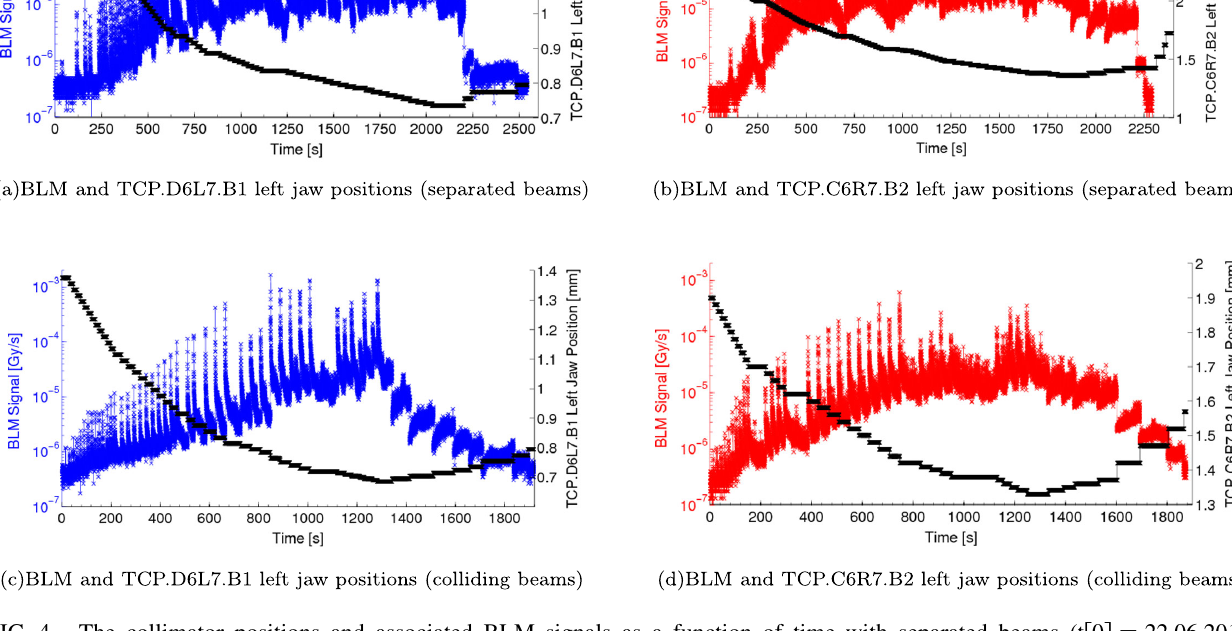
FIG. 4. The collimator positions and associated BLM signals as a function of time with separated beams ( t ½ 0 (cid:3) ¼ 22 : 06 : 2012 , 06:00:00) and colliding beams ( t ½ 0 (cid:3) ¼ 22 : 06 : 2012 , 07:00:00).